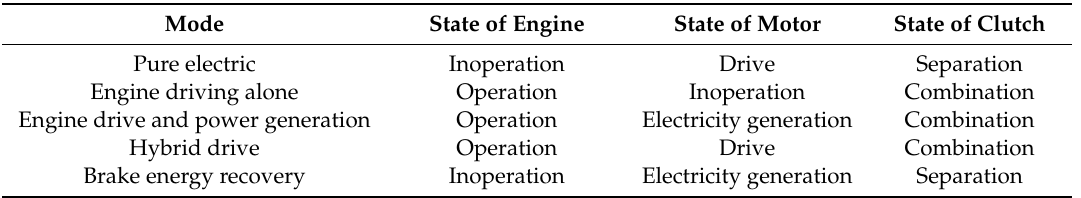
Table 2. System working